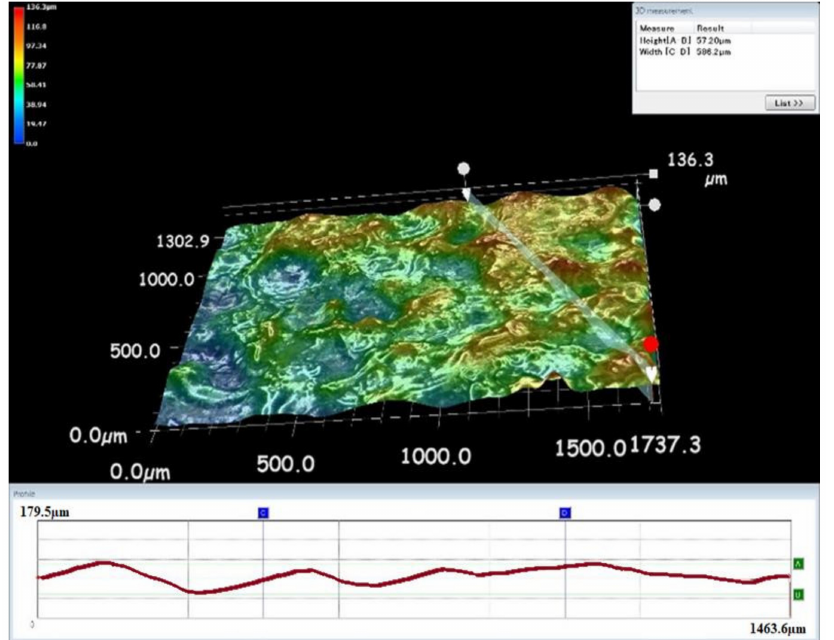
Figure 8. Surface morphology of the machined specimens under